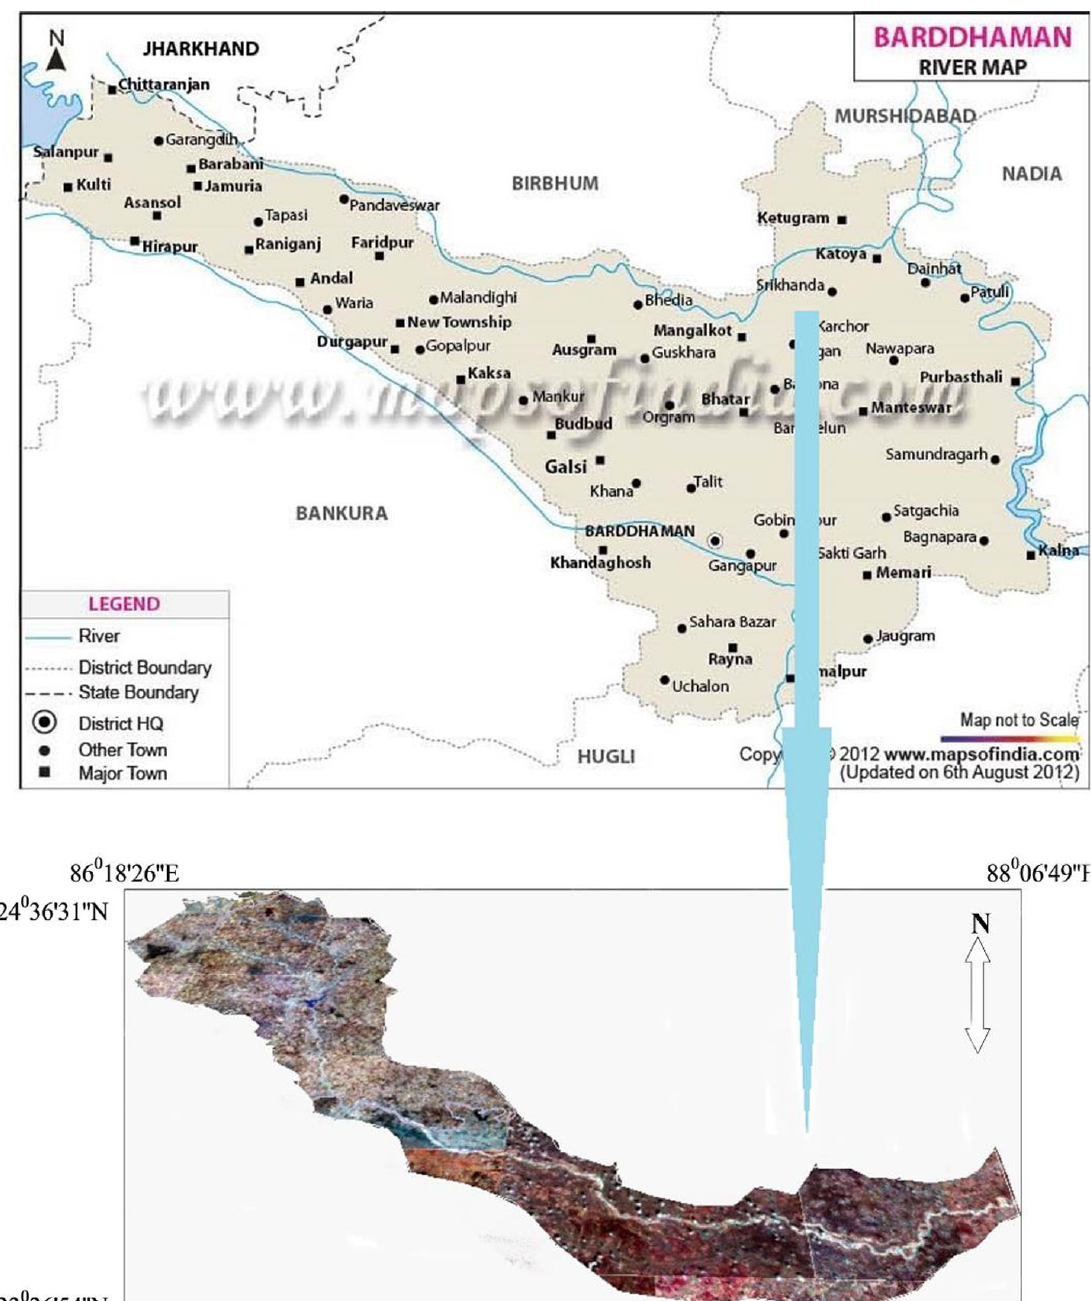
Figure 3: Study area of the Ajoy river catchment